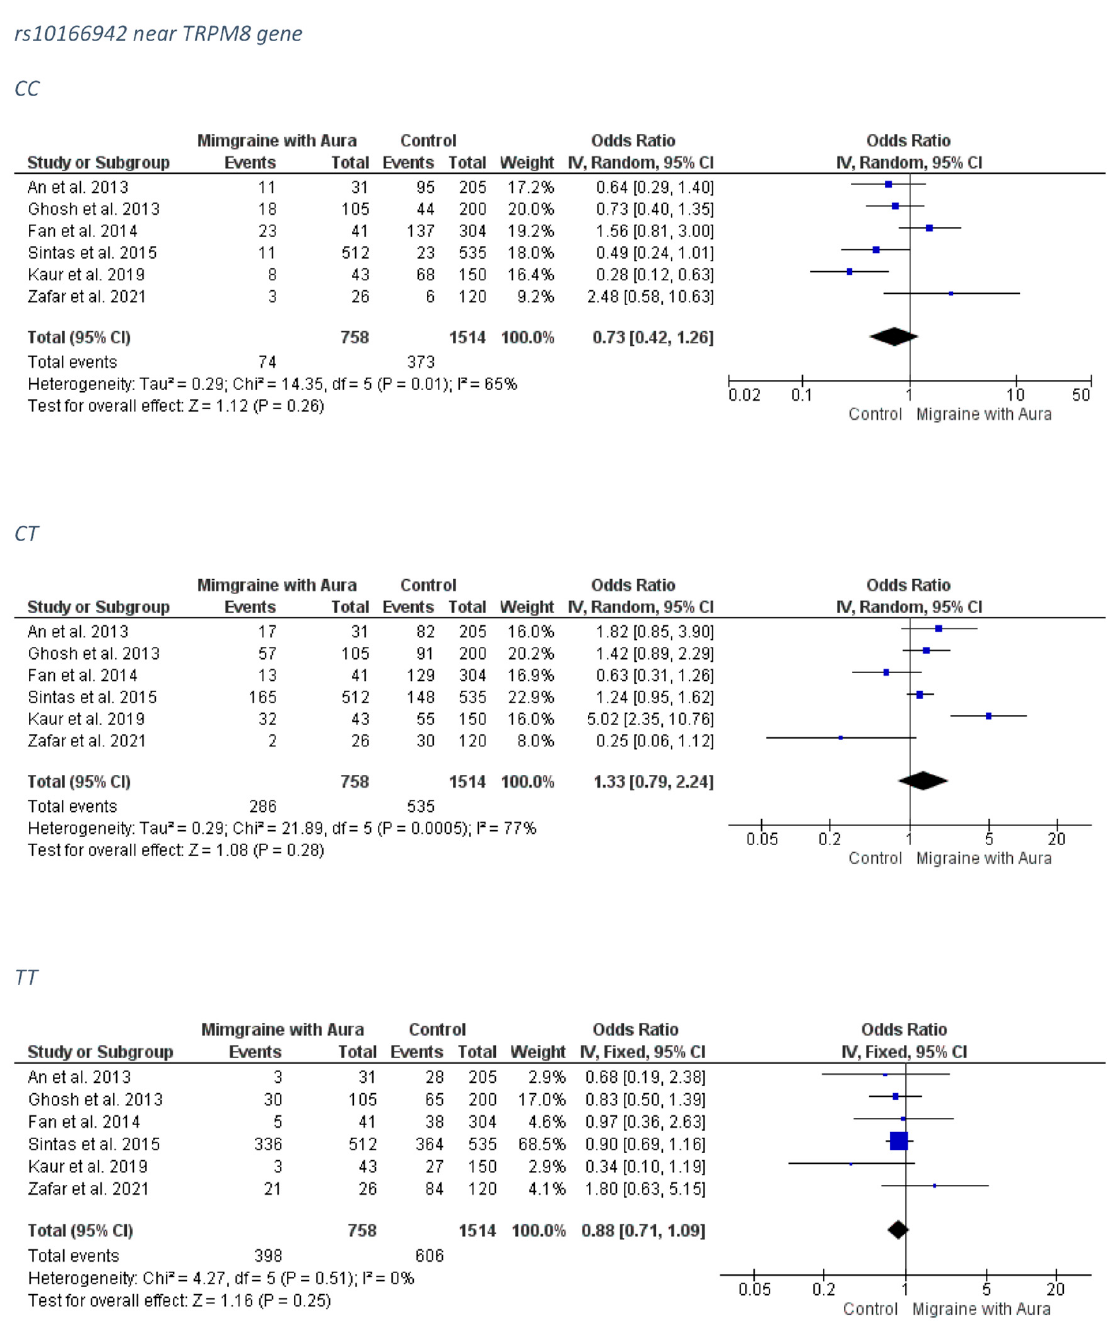
Figure 5. The forest plots presenting the results from meta-analysis of the rs10166942 and migraine with aura group .